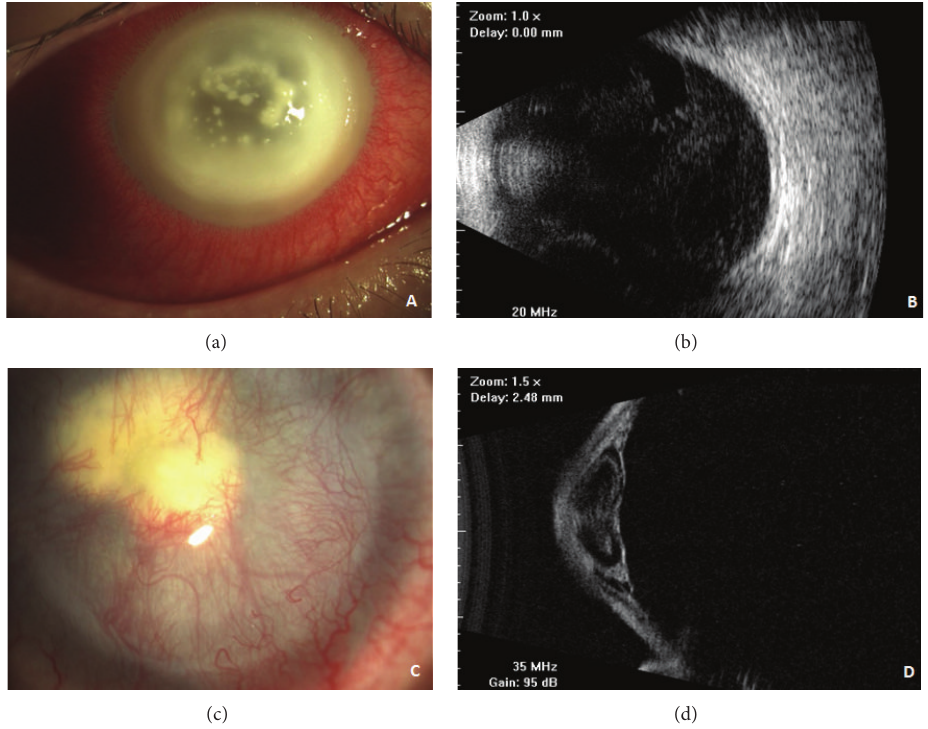
Figure 1: (a) Five days after CXL, slit-lamp examination revealed the presence of an annular corneal abscess, spared and scattered miliary infiltrates, and diffuse corneal edema with a strong inflammatory reaction in the ciliary body. The anterior chamber was not appreciable in detail. (b) Ultrasound B-scan showing vitreous reaction on postoperative day 7. (c) Slit-lamp image showing vascularized corneal pannus, with the presence of a dense leucoma in the center of the cornea. (d) Ultrastructural B-scan (UBM) evaluation showing the anteriorization of iris and lens planes, with the presence of angular synechiae and the absence of anterior chamber (2nd month after